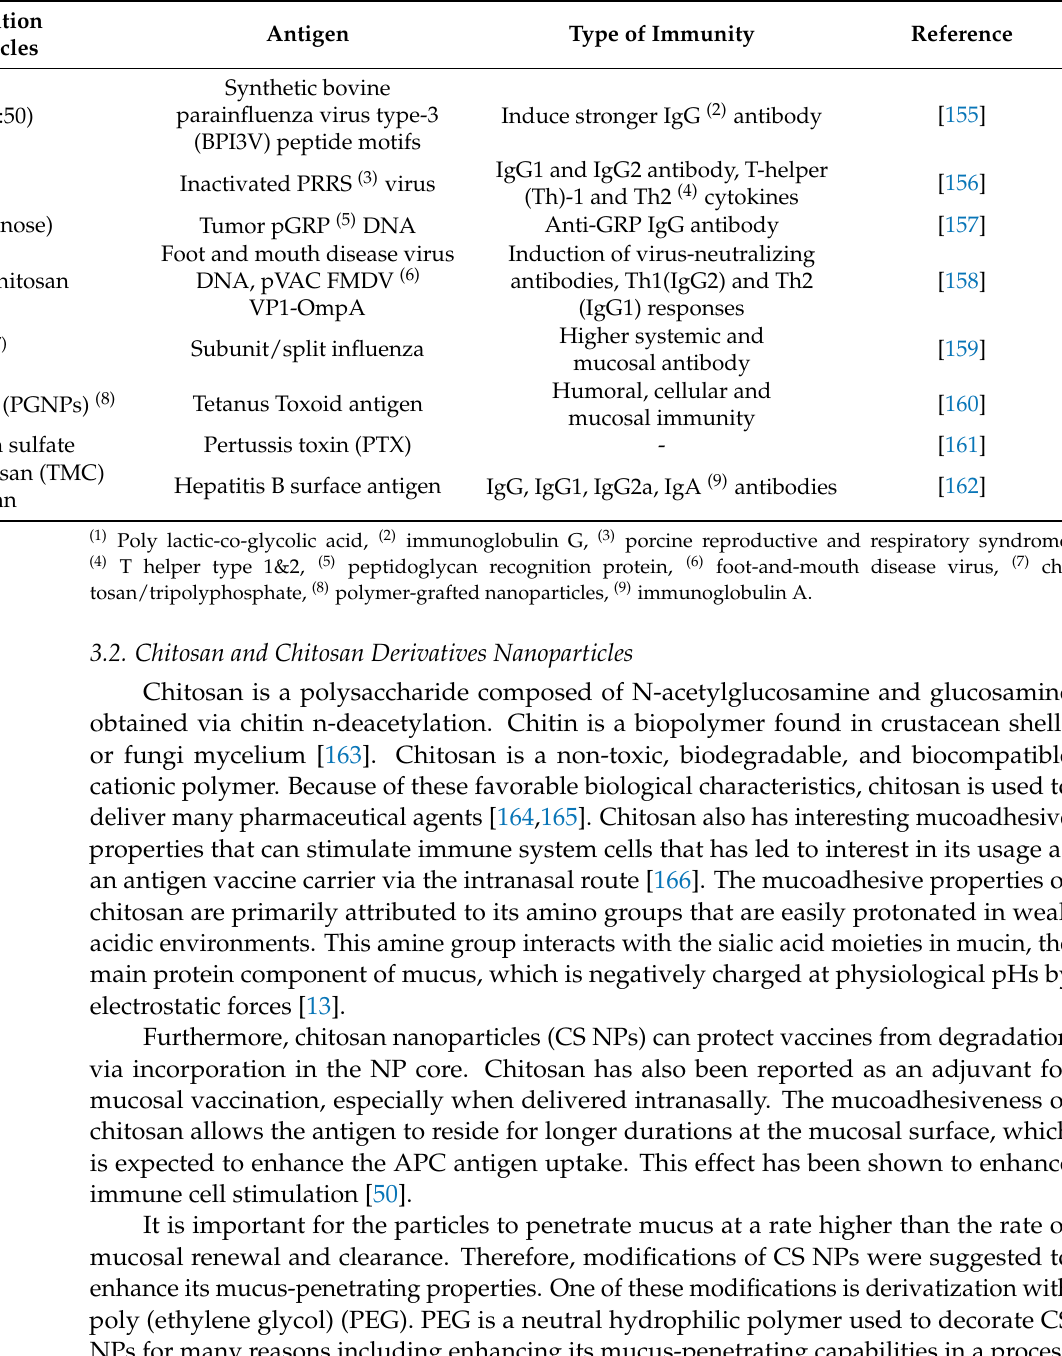
Table 1. Examples of polymeric nanoparticles used for intranasal vaccine